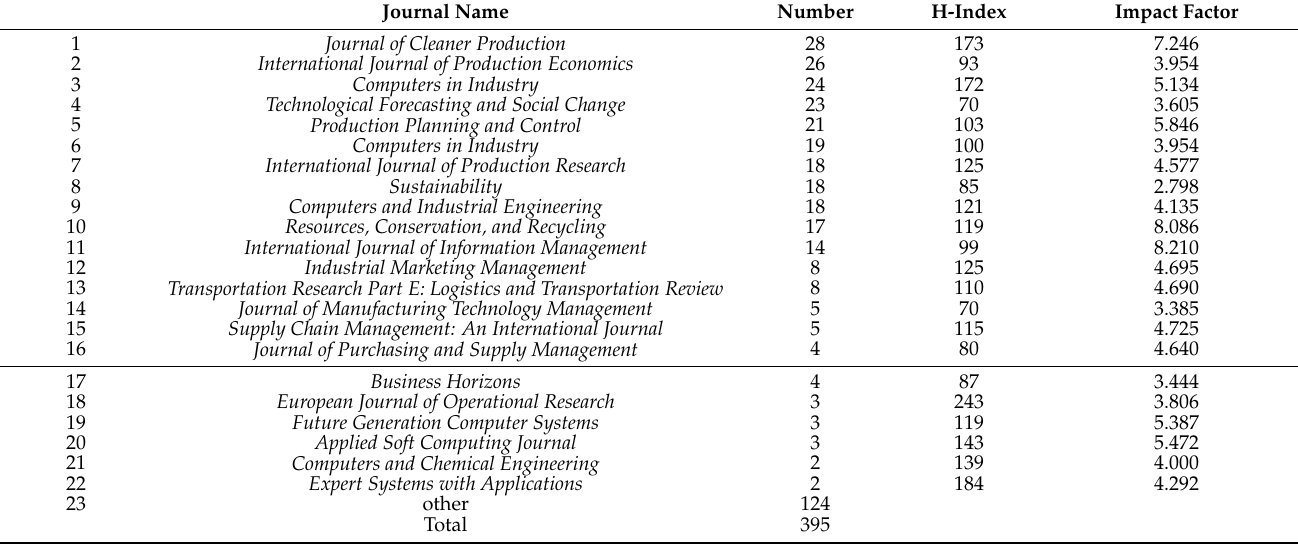
Figure 3. Keyword occurrence in the selected papers.